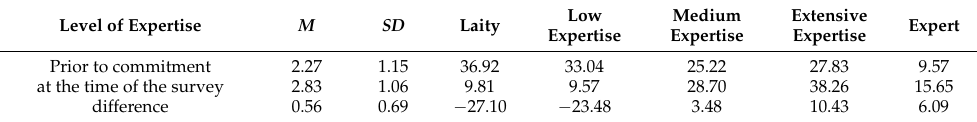
Table 3. Self-assessment of the level of expertise prior to the commitment and at the time of the survey 1 .